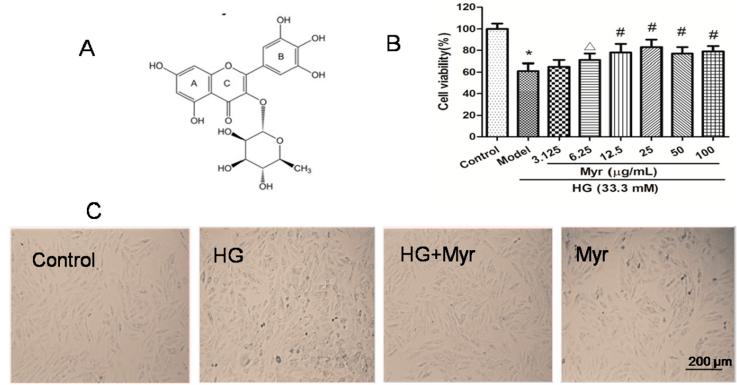
Figure 1. Structure of myricitrin and the effects of myricitrin on HG-induced H9c2 cell death and morphological changes. ( A ) The chemical structure of myricitrin; ( B ) Cell viability was assessed by the MTT assay. H9c2 cells were exposed to 33 mM glucose for 48 h in the presence or absence (Control) of myricitrin (25 μ g/mL); ( C ) Representative photomicrographs of H9c2 cells in various experimental groups with or without high glucose treatment. The bar represents 200 μ m. Values are represented as the mean ± SD ( n = 9). The results were representative of three independent experiments. * p < 0.01 vs. control; △ p < 0.05 vs. HG; # p < 0.01 vs. HG.